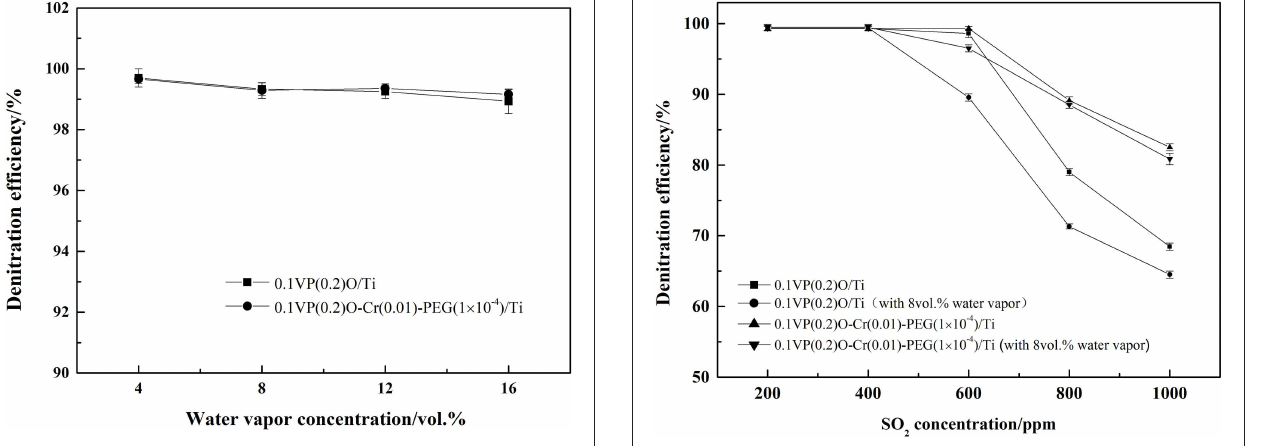
FIGURE 6 | Effect of water vapor on denitration efficiency.